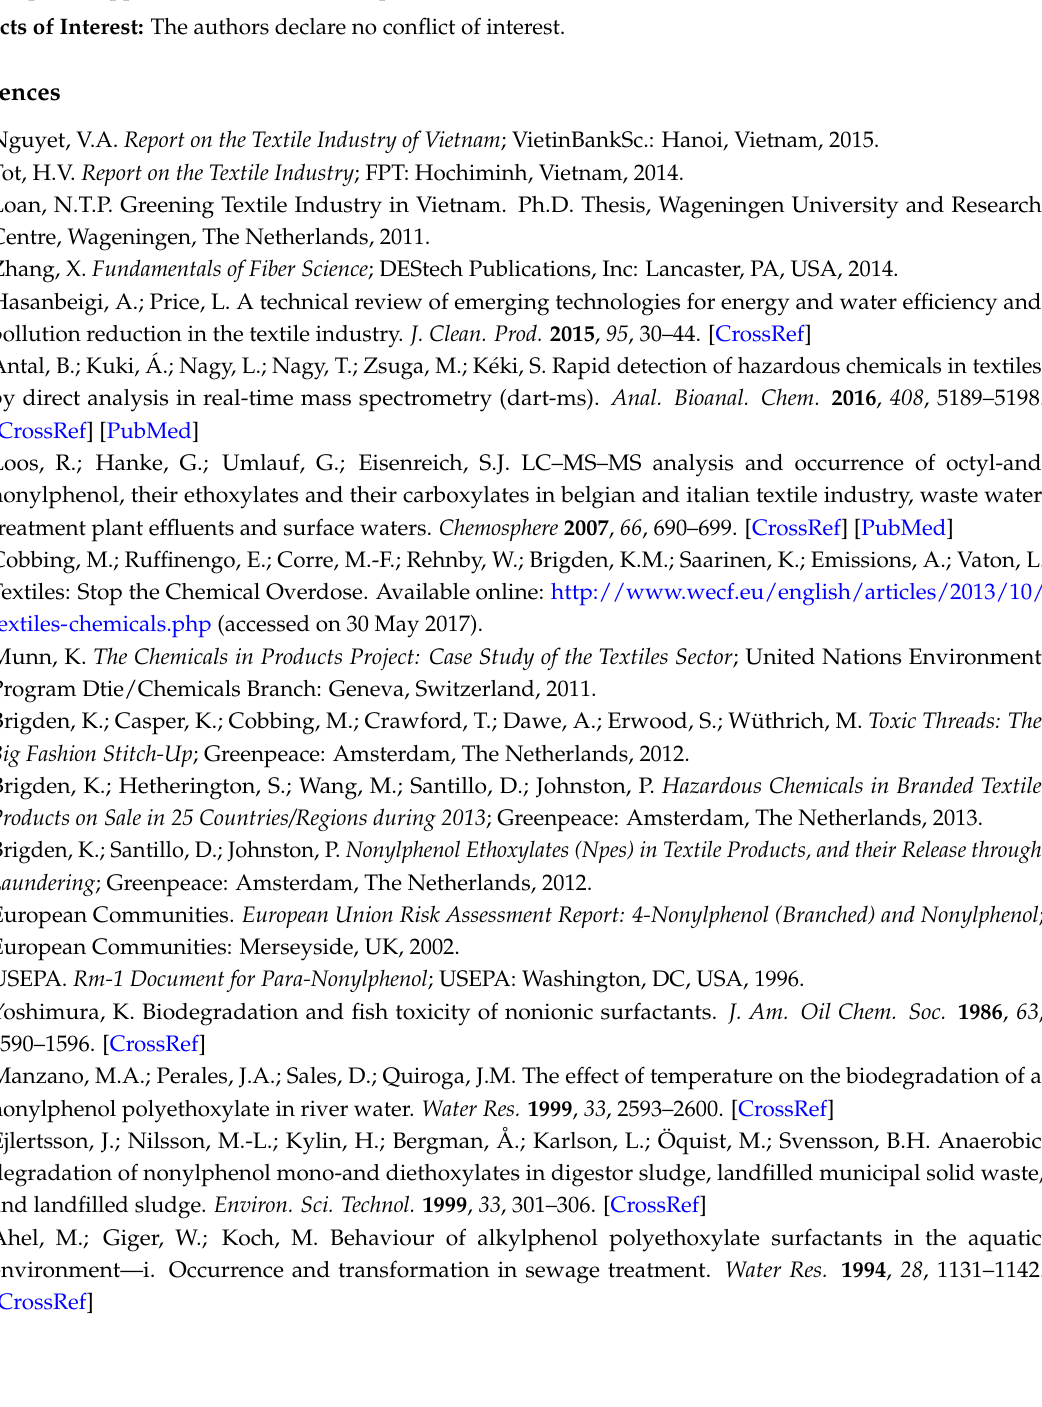
Table S1: MRM transitions of NP and